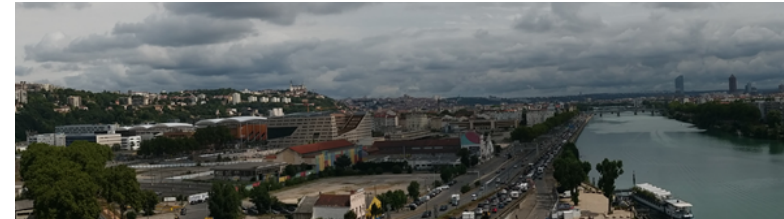
Figure 2. Viewpoint from south of Lyon.